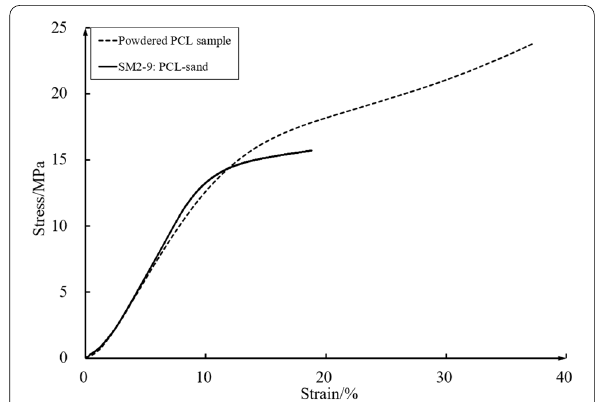
Fig. 15 Stress–strain relationship curves of the PCL‑sand sample and the powdered PCL